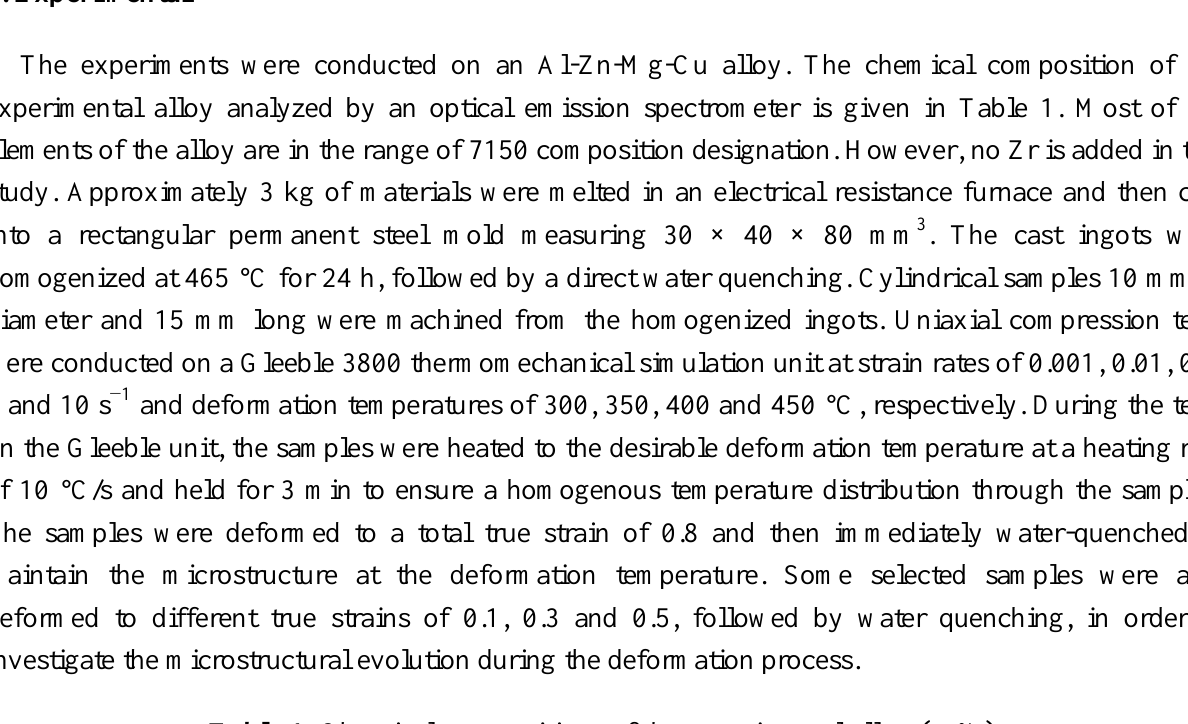
Table 1. Chemical compositions of the experimental alloy